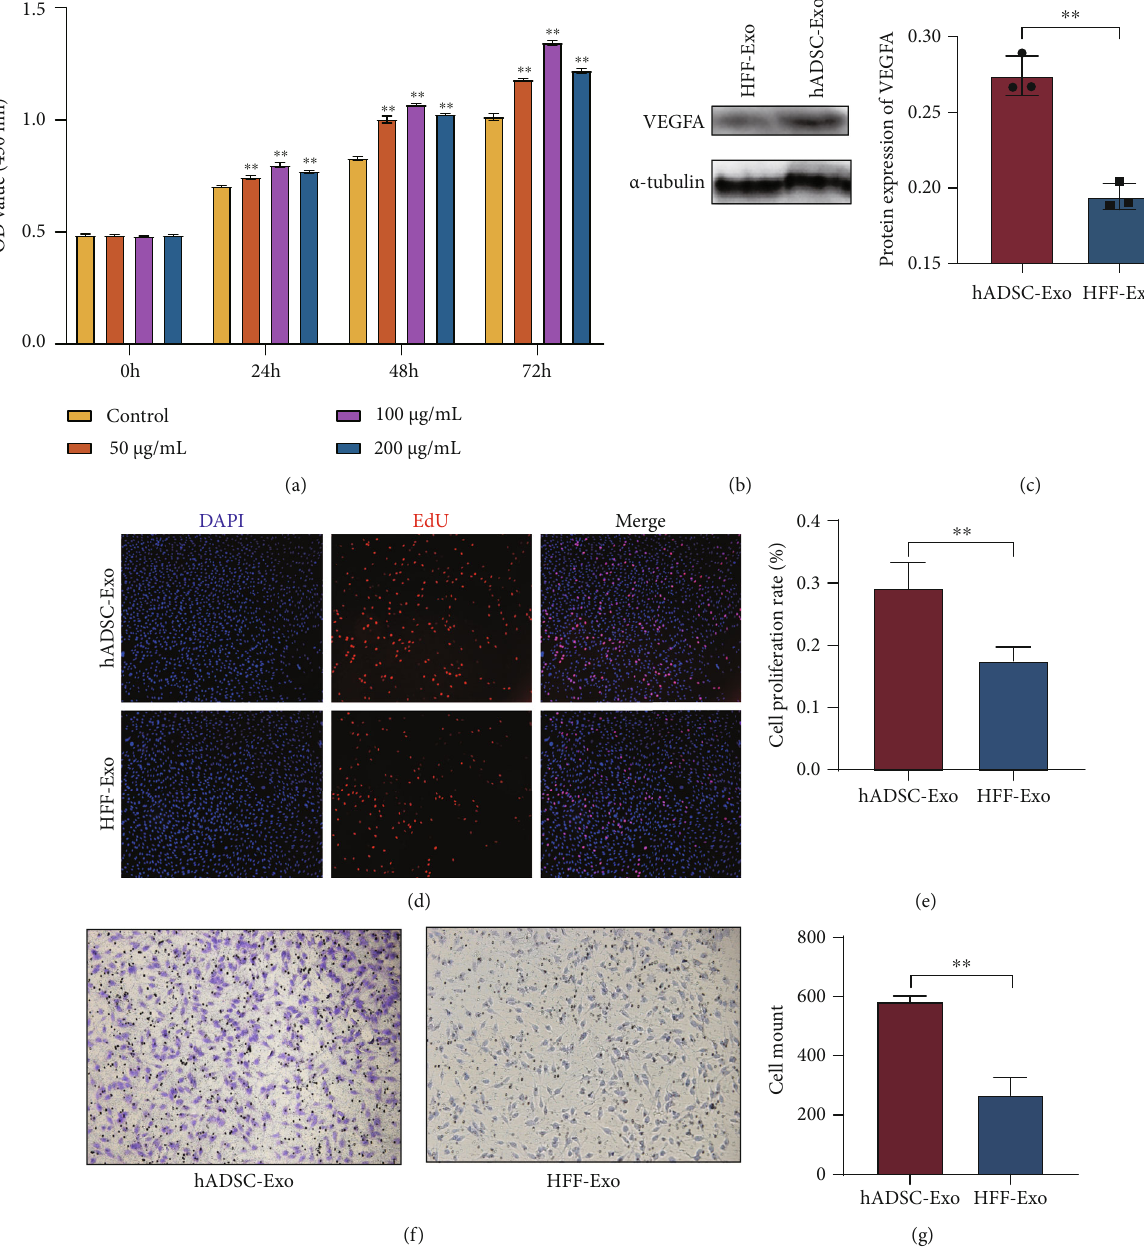
Figure 4: Proangiogenic e ff ects of hADSC-Exo in vitro. (a) The CCK8 revealed that 100 μ g/mL of hADSC-Exo had the most signi fi cant promotion e ff ect on the proliferation of HUVEC, and this promotion e ff ect persisted with increasing culture time. (b, c) The expression levels of VEGFA genes in fat grafts were treated with hADSC-Exo or HFF-Exo. (d) Proliferating HUVECs were stained with red fl uorescence, and all nuclei were stained with blue fl uorescence. (e) The cell proliferation rate of hADSC-Exo group was higher than that of HFF-Exo group. (f, g) The migration of HUVEC in the hADSC-Exo group was better than that in the HFF-Exo group. ( ∗∗ p < 0 : 01